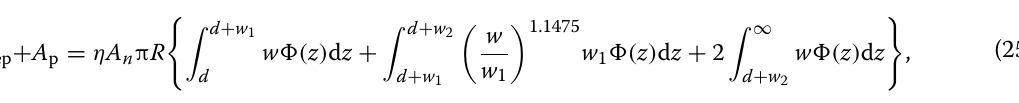
Table 1 Material properties of Larix gmelinii E L /MPa E R = E T /MPa ν LR ν